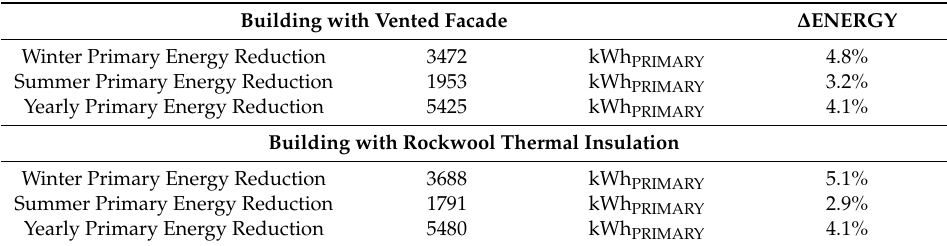
Table 6. Comparison, with respect to the base building, of the retrofit with thermal insulation and the retrofit with thermal insulation and vented façade.